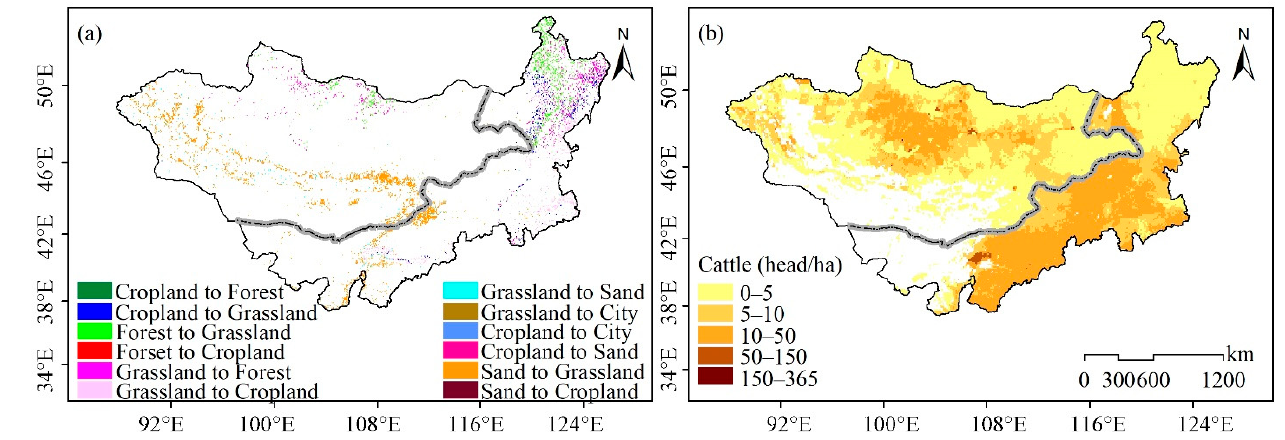
Figure 11. Distribution map of changes in land cover ( a ) and livestock ( b ) in the Mongolian Plateau.